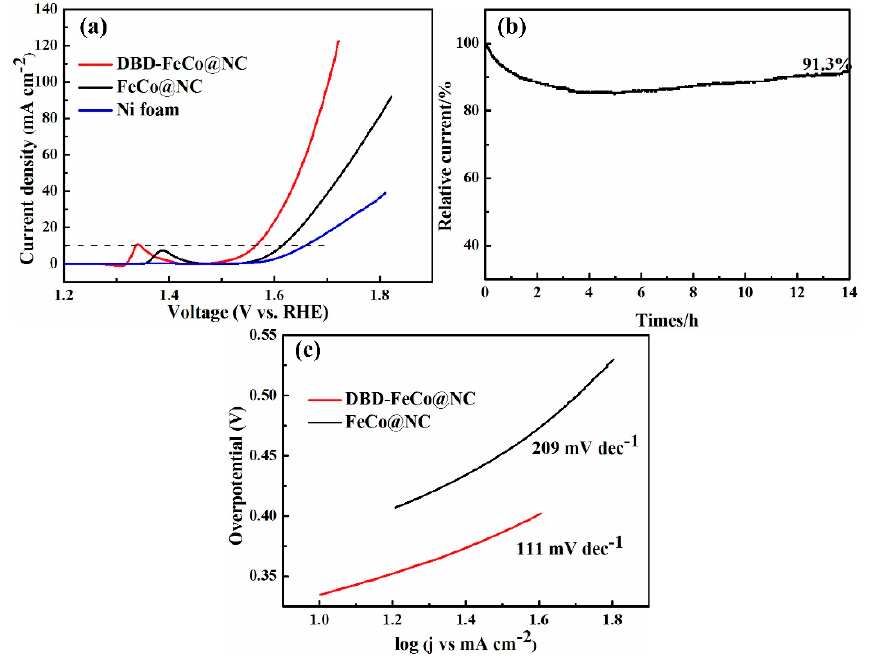
Figure 5. ( a ) The LSV polarization curves and ( b ) Tafel slope of OER for FeCo@NC and DBD-FeCo@NC, ( c ) Galvanostatic measurement of OER of DBD-FeCo@NC at a current density of 10 mA cm − 2 .